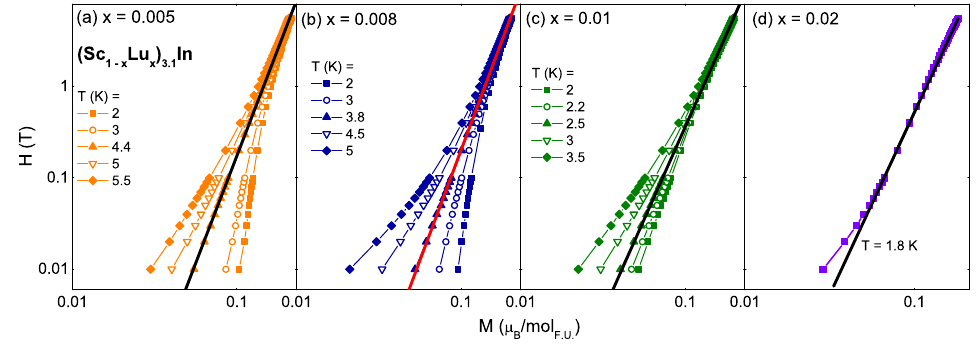
Þ FIG. 4. Log-log ð Sc 1 − Lu 3 . 1 In M(H) isotherms for (a) x x x critical ( T ¼ T ) isotherm. (d) Log-log M ð H Þ curve for x ¼ 0 . 02 and T ¼ 1 . 8 K, with a linear fit above H ¼ 0 . 05 C